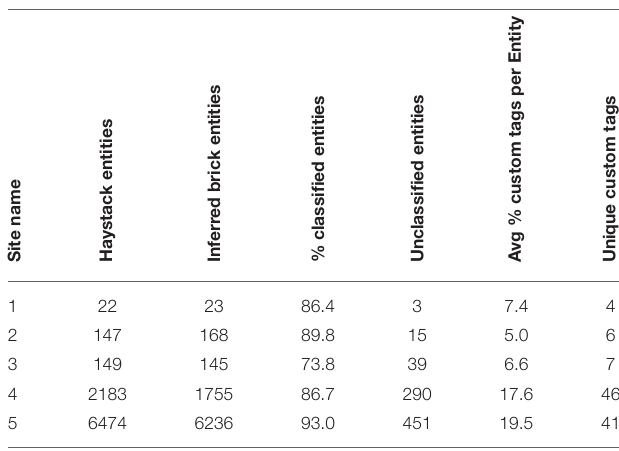
TABLE 5 | Results of inferring Brick entities from tagged Haystack